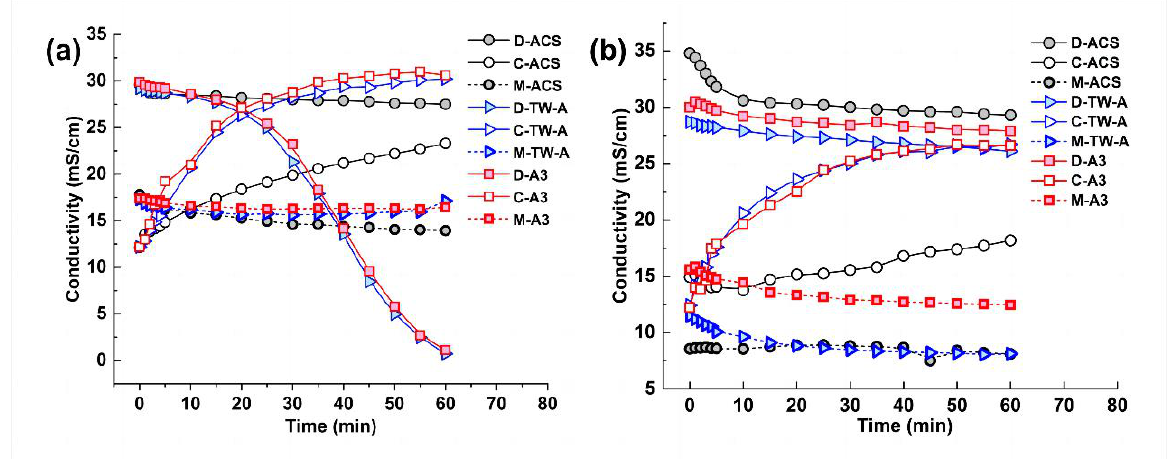
Figure 5. Conductivity versus time for desalination chamber (D), concentration chamber (C), and metathesis chamber (M) for different anion membranes ( a ) for tobacco simulants Tobacco extract; conductivity versus time for desalination chamber (D), concentration chamber (C), and metathesis chamber (M) for different anion membranes ( b ).